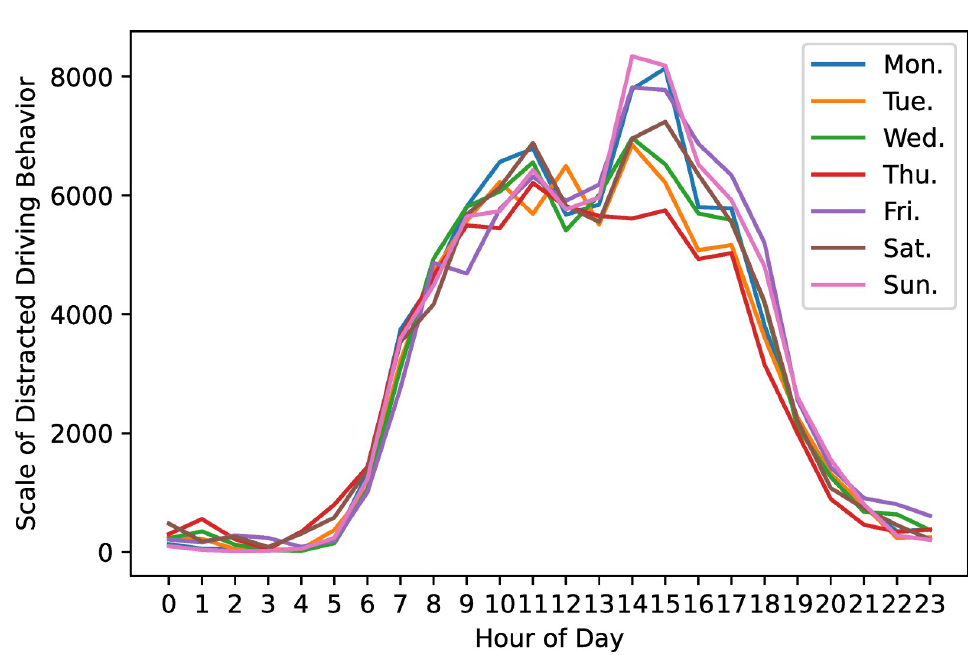
Fig 5. Daily average number of distracted driving